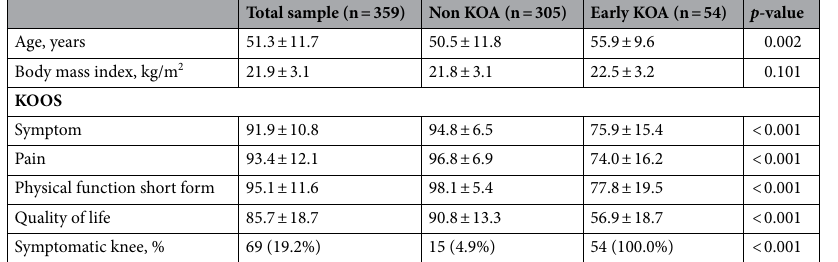
Table 1. The demographic data of study participants. Values are means ± standard deviations of age, body mass index, and KOOS. In regards to symptomatic knee, values are represented by prevalence (percentage of the whole population). Differences among the two groups were compared by Mann–Whitney U test and chi-square test. A p -value indicates the significance of difference between participants with and without knee symptoms. KOOS Knee injury and Outcome